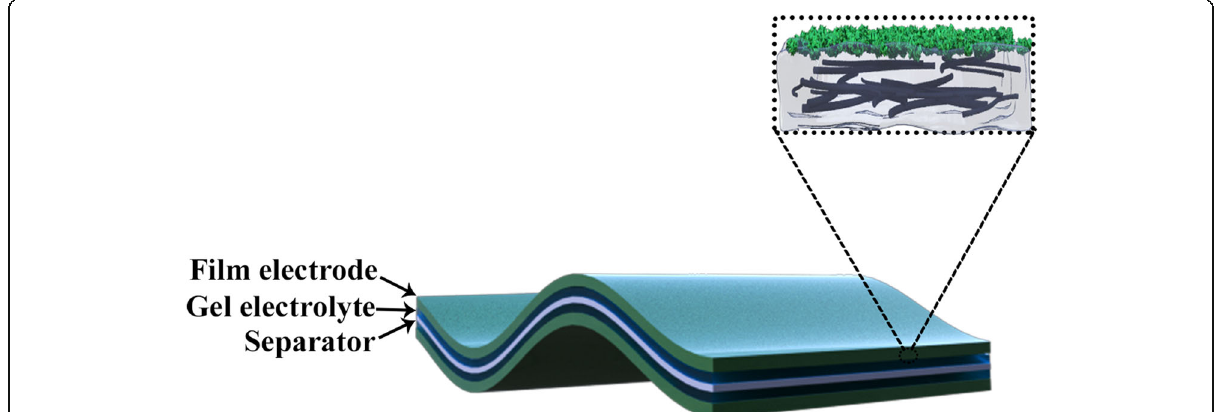
Fig. 1 Schematic illustration of symmetric supercapacitor based on PVA/CNT/PANI electrodes and gel electrolyte